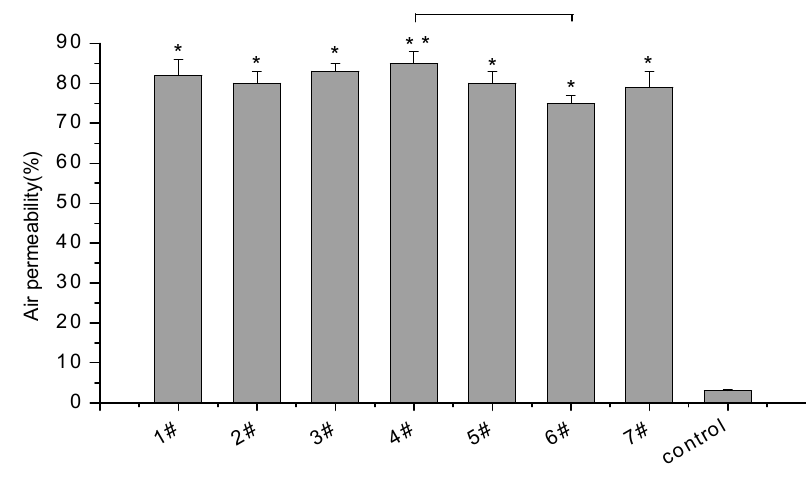
Figure 2. Air permeability of the composite films.